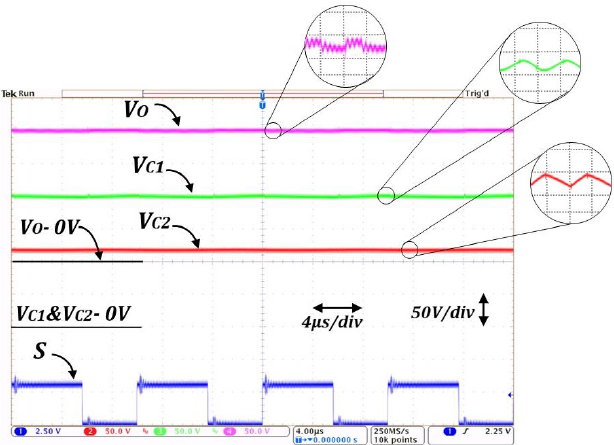
Figure 25. Switching function “ s ” , capacitors and output voltage ( V g = 85 V , V o = 200 V , P o = 400 W ).